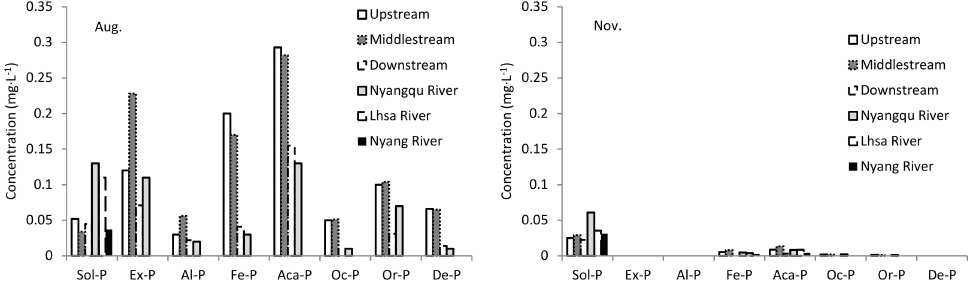
Figure 7. Morphological distribution of